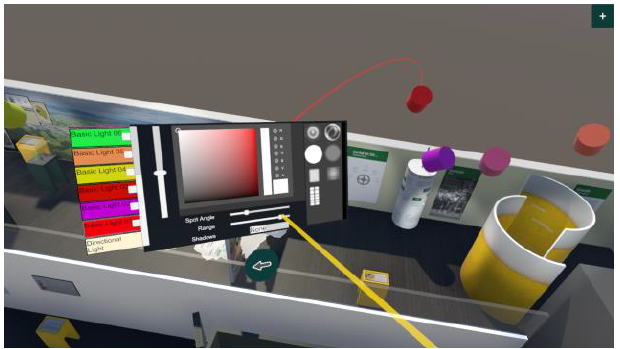
Figure 17. Light settings can be adjusted in terms of color, intensity, spot angle and other options.